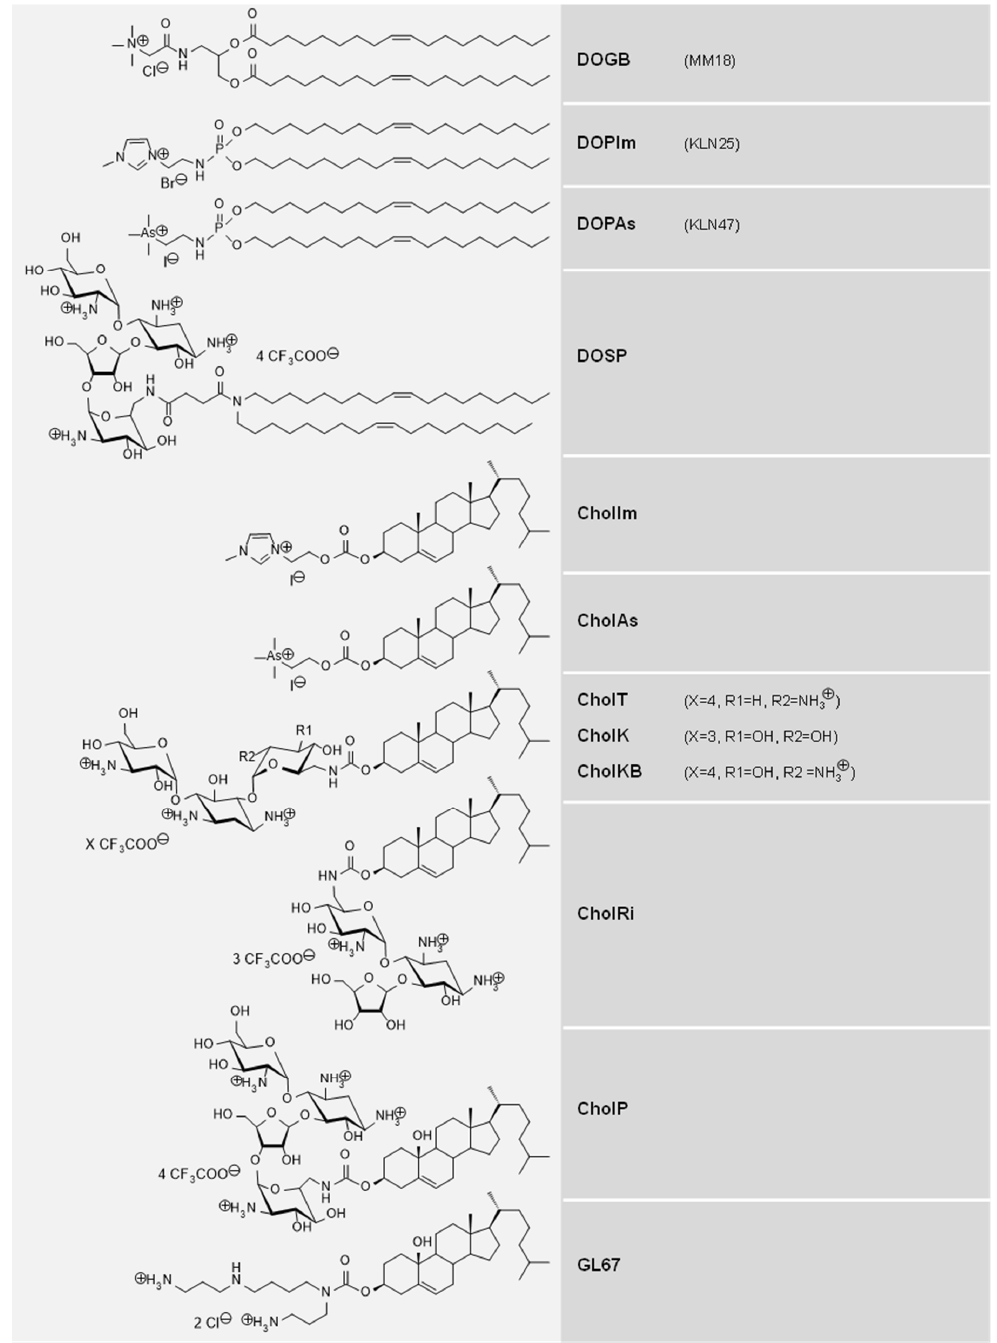
Figure 1. Chemical structure of the cationic lipids considered in this study. DOGB, dioleyl glycine betaine; DOPIm, dioleyl phosphoramide imidazolium; DOPAs, dioleyl phosphoramide arsonium; DOSP, dioleyl-succinyl paromomycin; CholIm, cholesterol imidazolium; CholAs, cholesterol arson- ium; CholT, cholesterol tobramycin; CholK, cholesterol kanamycin A; CholKB, cholesterol kanamycin B; CholRi, cholesterol ribostamycin; CholP, cholesterol paromomycin; GL67, Genzyme (Cambridge, MA, USA) lipid 67